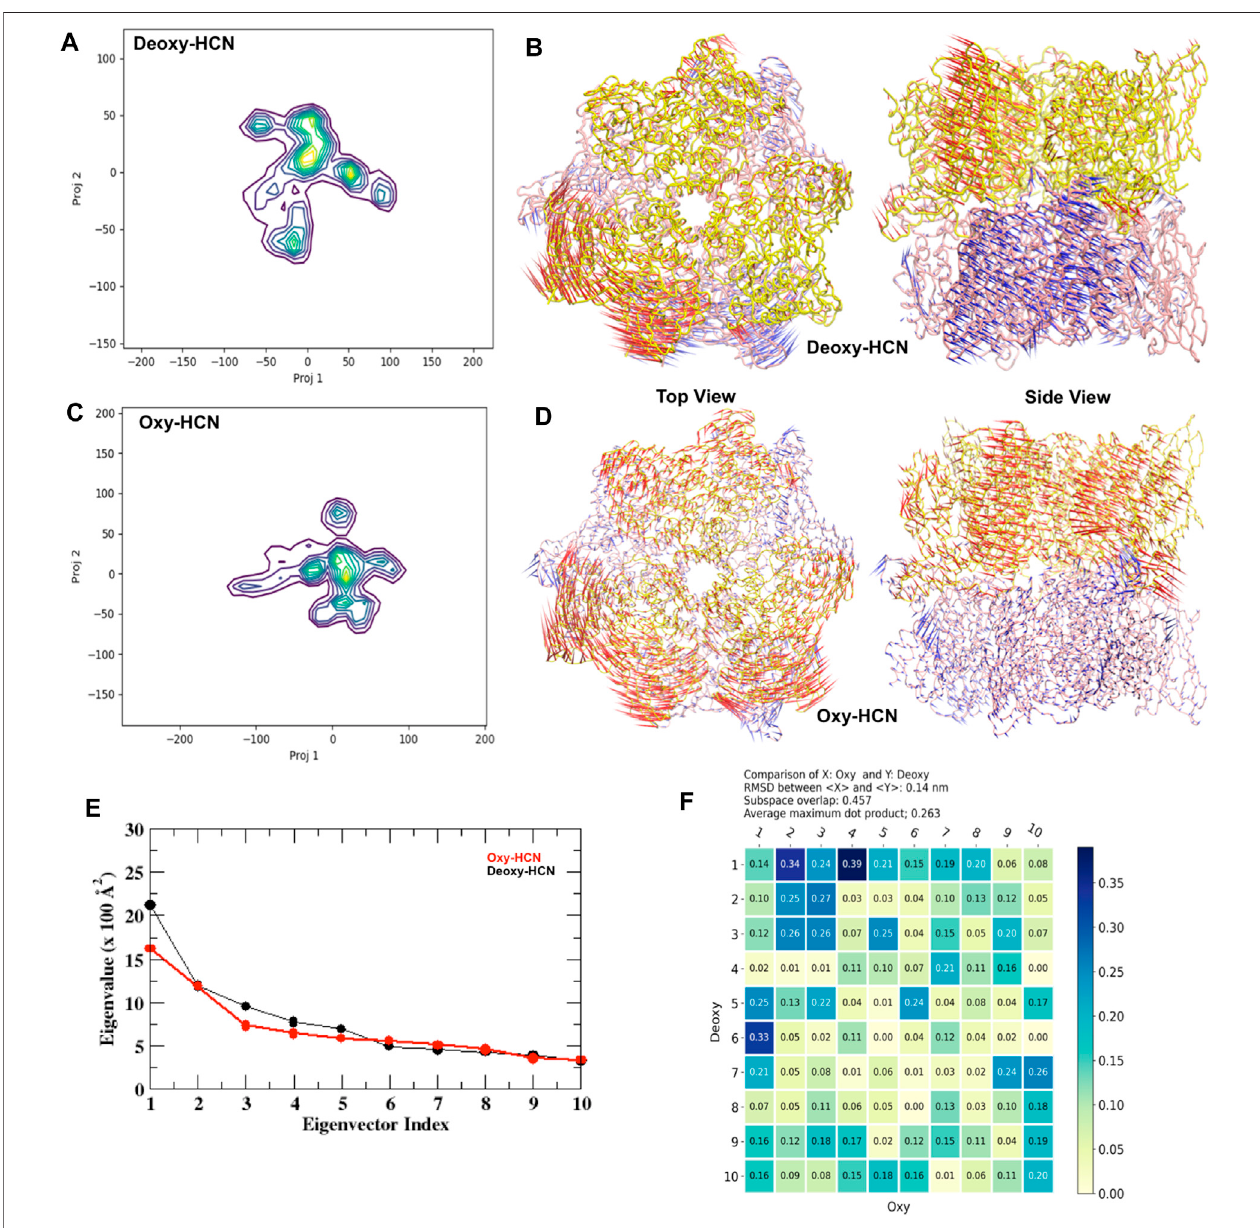
FIGURE 6 | Principal component analysis (PCA). (A) Projections 1 and 2 from Deoxy-HCN represented as a heat map. (B) Top and side view of principal component 1 from Deoxy-HCN. (C) Projections 1 and 2 from Oxy-HCN represented as a heat map. (D) Top and side view of principal component 1 from Deoxy-HCN. (E) A scree plot comparing the eigenvalue versus eigenvector index in the two systems. (F) A subspace analysis between Deoxy-HCN and